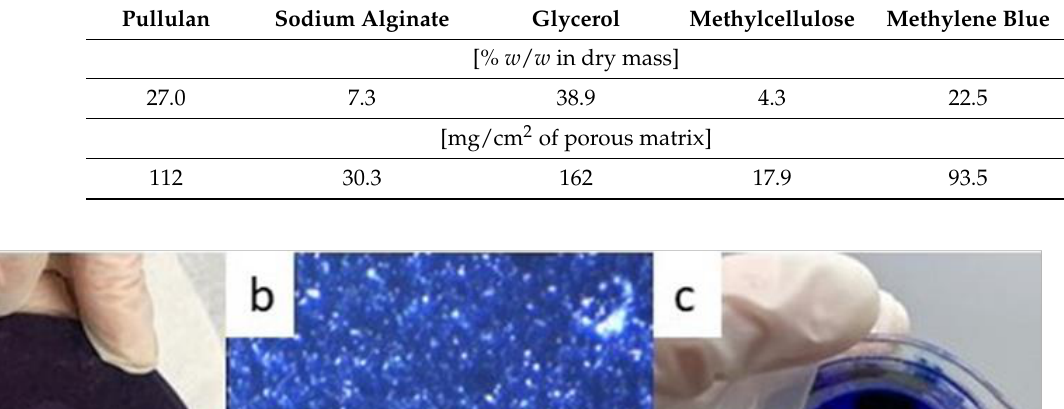
Table 1. Methylene blue-loaded porous matrices composition. Pullulan Sodium Alginate Glycerol Methylcellulose Methylene Blue